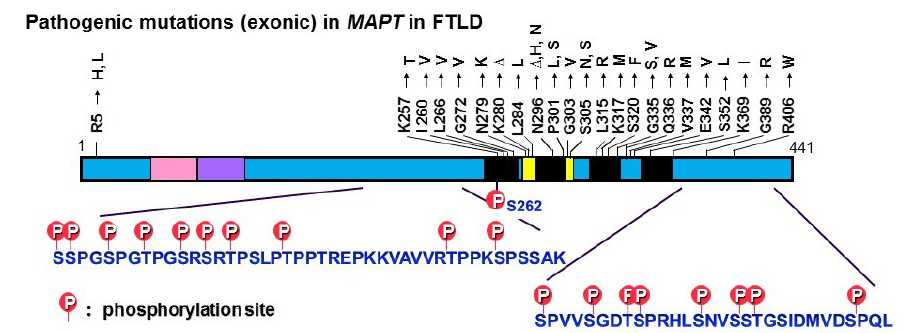
Exonic mutations in the tau gene ( MAPT ) reported in FTDP-17T and major tau phosphorylation sites identified in PHF-tau from AD brains. Most of the pathogenic mutations are located in the microtubule binding regions, whereas the phosphorylation sites are located outside these